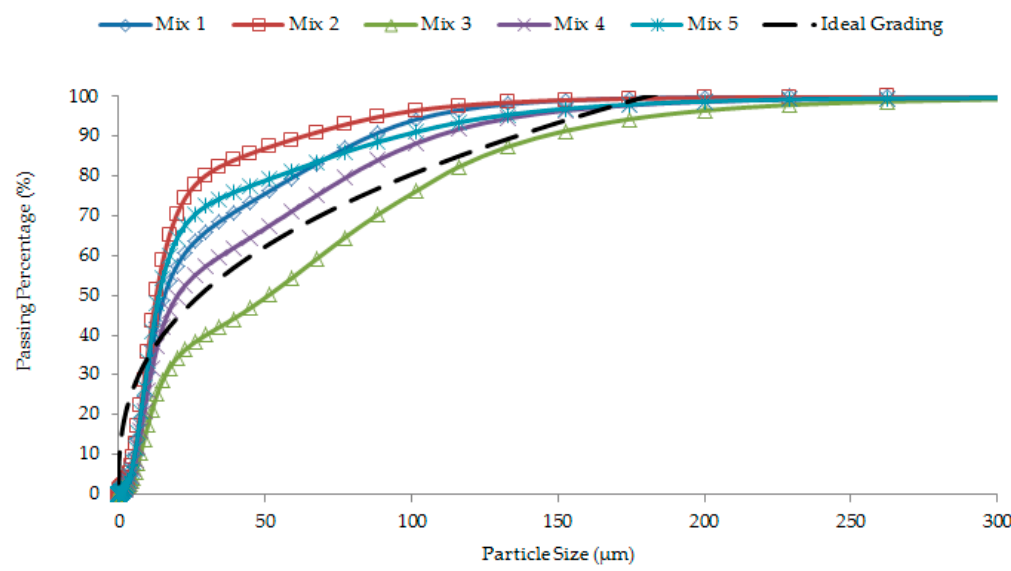
Figure 5. Optimum particle grading of the designated concrete mixes.